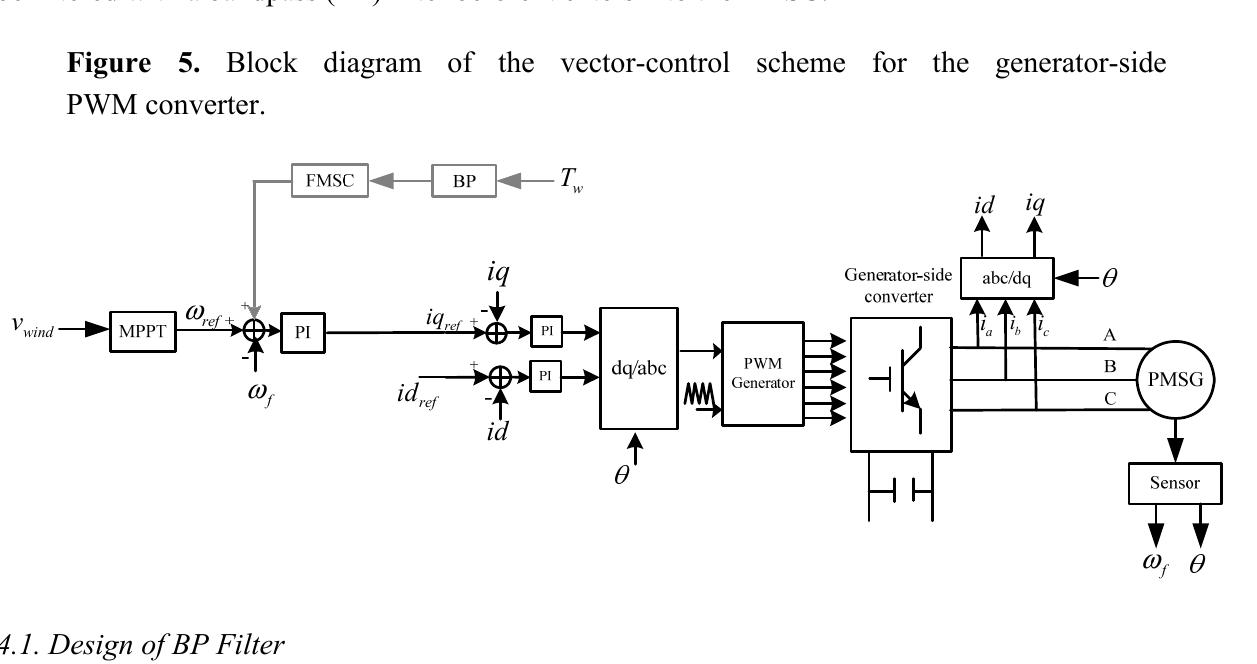
Figure 5. Block diagram of the vector-control scheme for the generator-side PWM converter.